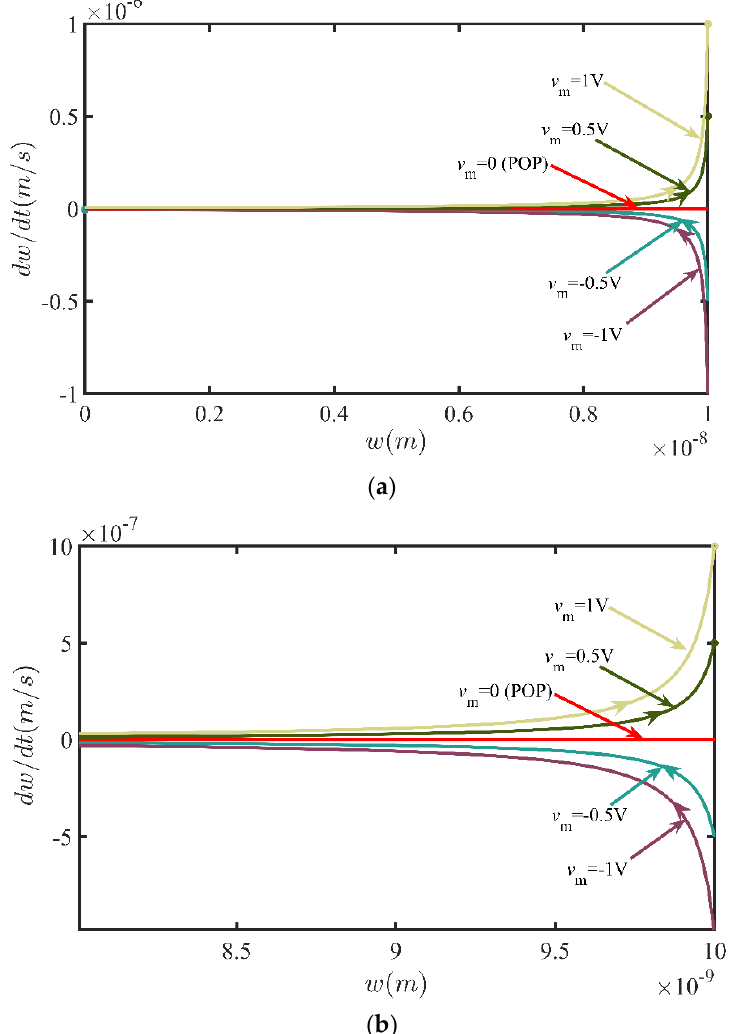
Figure 1. The dynamic route of the Hewlett-Packard (HP) TiO 2 memristor, in which the red line is the power-off plot (POP); that is, the relationship between dw Local zoom-in of ( a ). Note that the small circles in the curve indicate that the curve cannot obtain the value of that point.